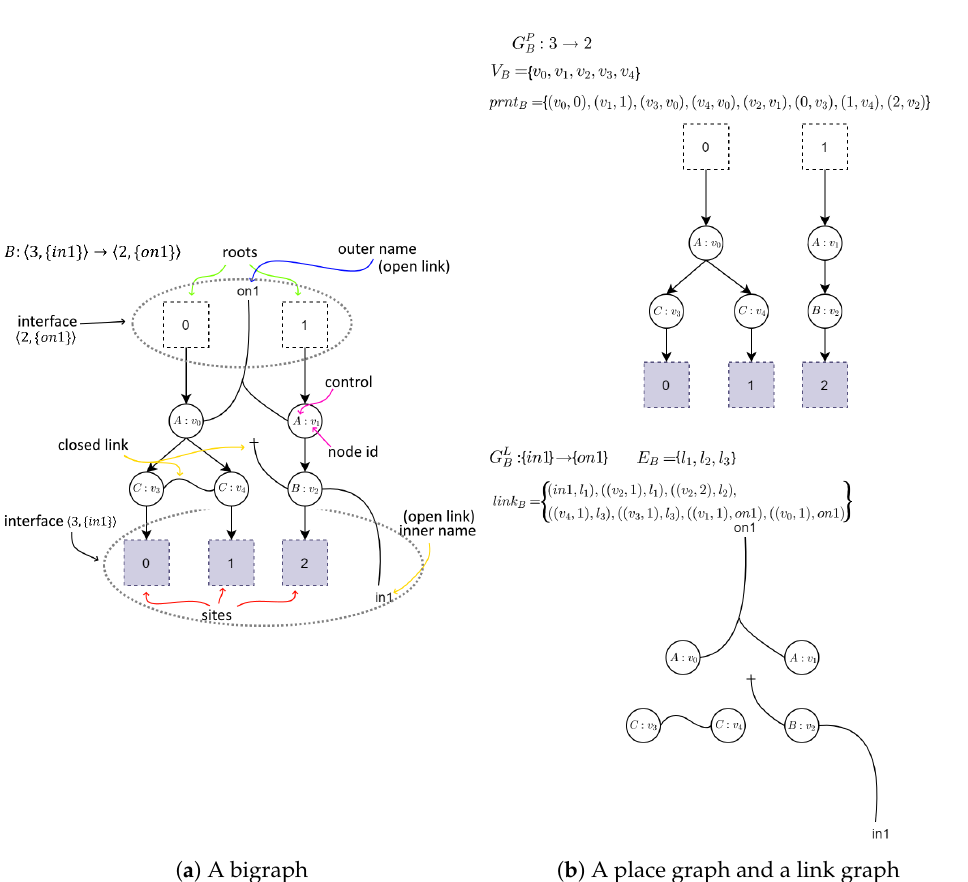
Figure 1. An example of a bigraph and its constituents. The right part represents a place graph (the upper part of the figure) and a link graph (the lower part of the figure). They share a signature which defines control types (letters in nodes) and arity of each control (number of unique links that can be connected to a node with specified control). On the left there is the bigraph made from the superposition of them